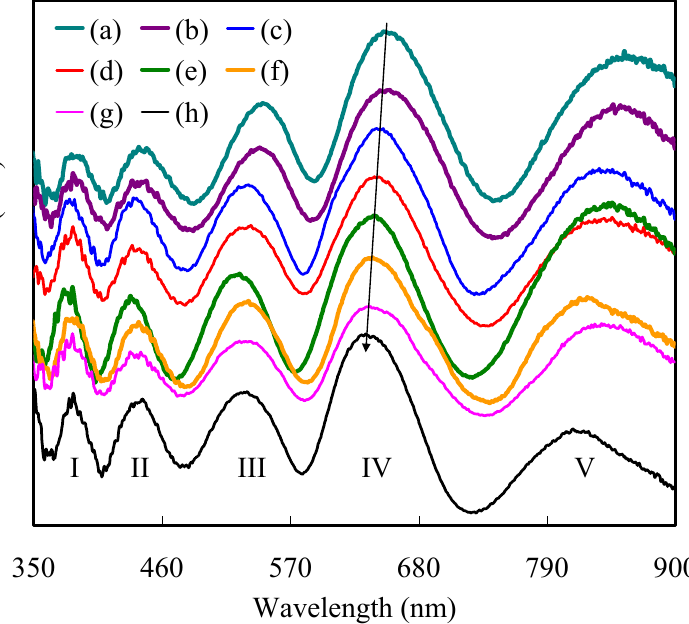
where P 0 and P i represent the reflectance peak wavelengths of abY ‐ grafted SPHR after agY treatment at concentrations of 0 and i pg mL − 1 , respectively. Peaks IV and V = 3) for agY were calculated as 51.3 and 12.3 pg mL − 1 using linear regression equations for were selected to evaluate sensing performance because of their increased blue shifts upon peaks IV and V, respectively. agY treatment.